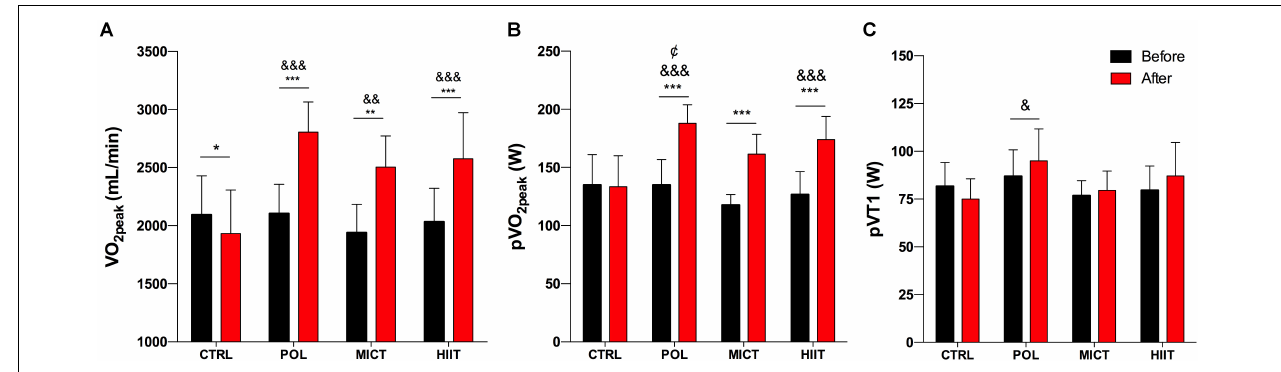
FIGURE 3 | Effects of training intervention on cardiorespiratory capacity. (A) Peak oxygen uptake (VO 2 peak), (B) power at VO 2 peak (pVO 2 peak), and (C) power at VT1 (pVT1) before and after 12-weeks of control (CTRL), polarized volume training (POL), moderate-intensity endurance training (MICT), and high-intensity interval training (HIIT). Data are shown as mean ± SD. ∗ , ∗∗ , and ∗∗∗ denote differences between pre and post-training values ( p < 0.05, p < 0.01, and p < 0.001, respectively). & , && , and &&& denote differences vs. CRTL group after intervention ( p < 0.05, p < 0.01, and p < 0.001, respectively). / c Denote differences between POL and MICT groups after intervention ( p < 0.05). The comparison was performed with Mixed Factorial ANOVAs with Bonferroni’s post hoc test for multiple comparisons.